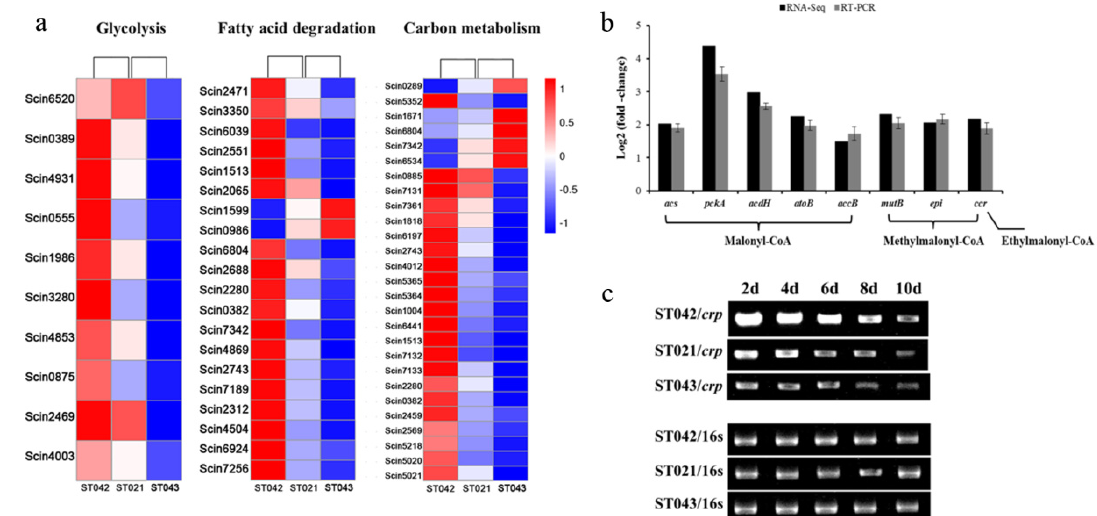
Figure 4. Transcription analysis of selected primary metabolic genes. ( a ) Heat maps of 57 DEGs enriched in the processes of glycolysis (10), fatty acid degradation (20) and carbon metabolism (27). Gene names involved are listed beside each heat map. ( b ) The relative transcriptional levels of primary metabolic genes in precursor biosynthesis in the crp overexpression strain ST042 by RNA-Seq and RT-PCR. Those in the original strain ST021 were set to 1.0 (arbitrary units). acs , acetyl-CoA synthetase gene; pckA , phosphoenolpyruvate carboxykinase gene; acdH , acyl-CoA dehydrogenase gene; atoB , acetyl-CoA acetyltransferase gene; accB , acyl-CoA carboxylase complex B subunit gene; mutB , coenzyme B12-dependent methylmalonyl-CoA mutase B subunit gene; epi , methylmalonyl-CoA epimerase gene; ccr , crotonyl-CoA reductase gene. Error bars indicate standard deviations from three independent experiments. ( c ) The crp transcription of ST042, ST021 and ST043 at different intervals.